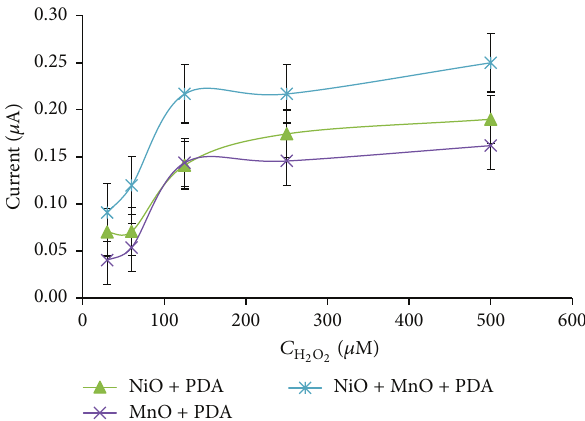
Figure7:Amperometricresponseformodifiedgoldelectrodeswith different concentration of H 2 O 2 at applied potential of 0.7